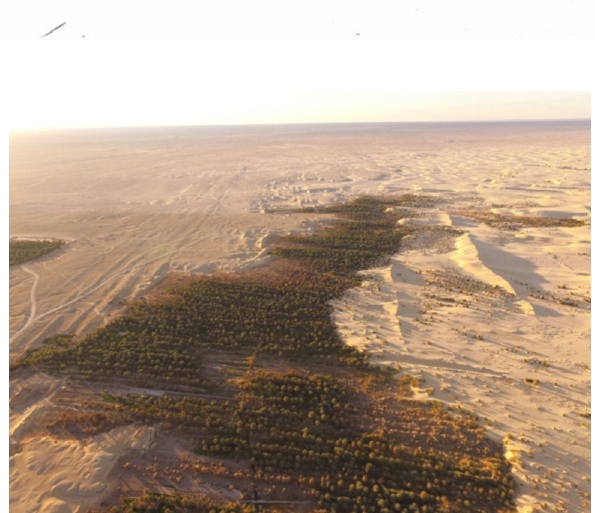
Fig. 11 A view of soil salinization in the oasis of Bouda. (photo.